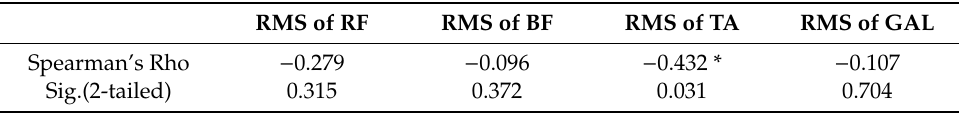
Table 7. The correlation between RMS and subjective fatigue RPE of each targeted muscle in the constant load